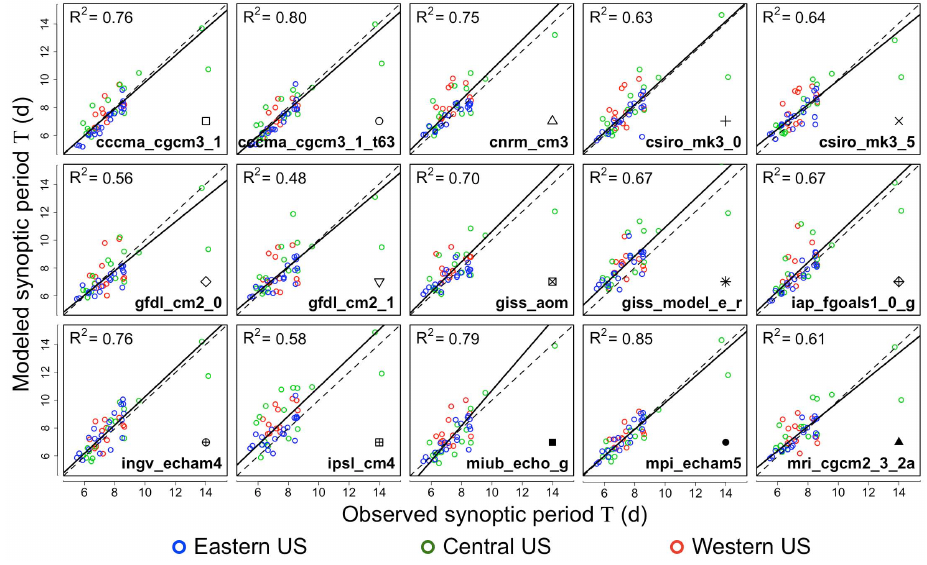
Fig. 4. Scatterplots of modeled vs. observed synoptic periods T of the dominant meteorological modes for interannual PM 2 . 5 variability in the US for 1981–2000. Observed values are from NCEP/NCAR Reanalysis 1, and modeled values are from 15 IPCC AR4 GCMs. GCM names are given in each panel, and the symbol above each name is used to identify the model in Figs. 5 and 7. Each data point represents T for one 4 ◦ × 5 ◦ grid cell, and the ensemble of points represents the continental US separated as eastern (east of 95 ◦ W), central (110–95 ◦ W), and western (west of 110 ◦ W). The solid black line is the reduced major-axis regression slope, with coefficient of variation ( R 2 ) also given. The 1 : 1 line is shown as dashed.